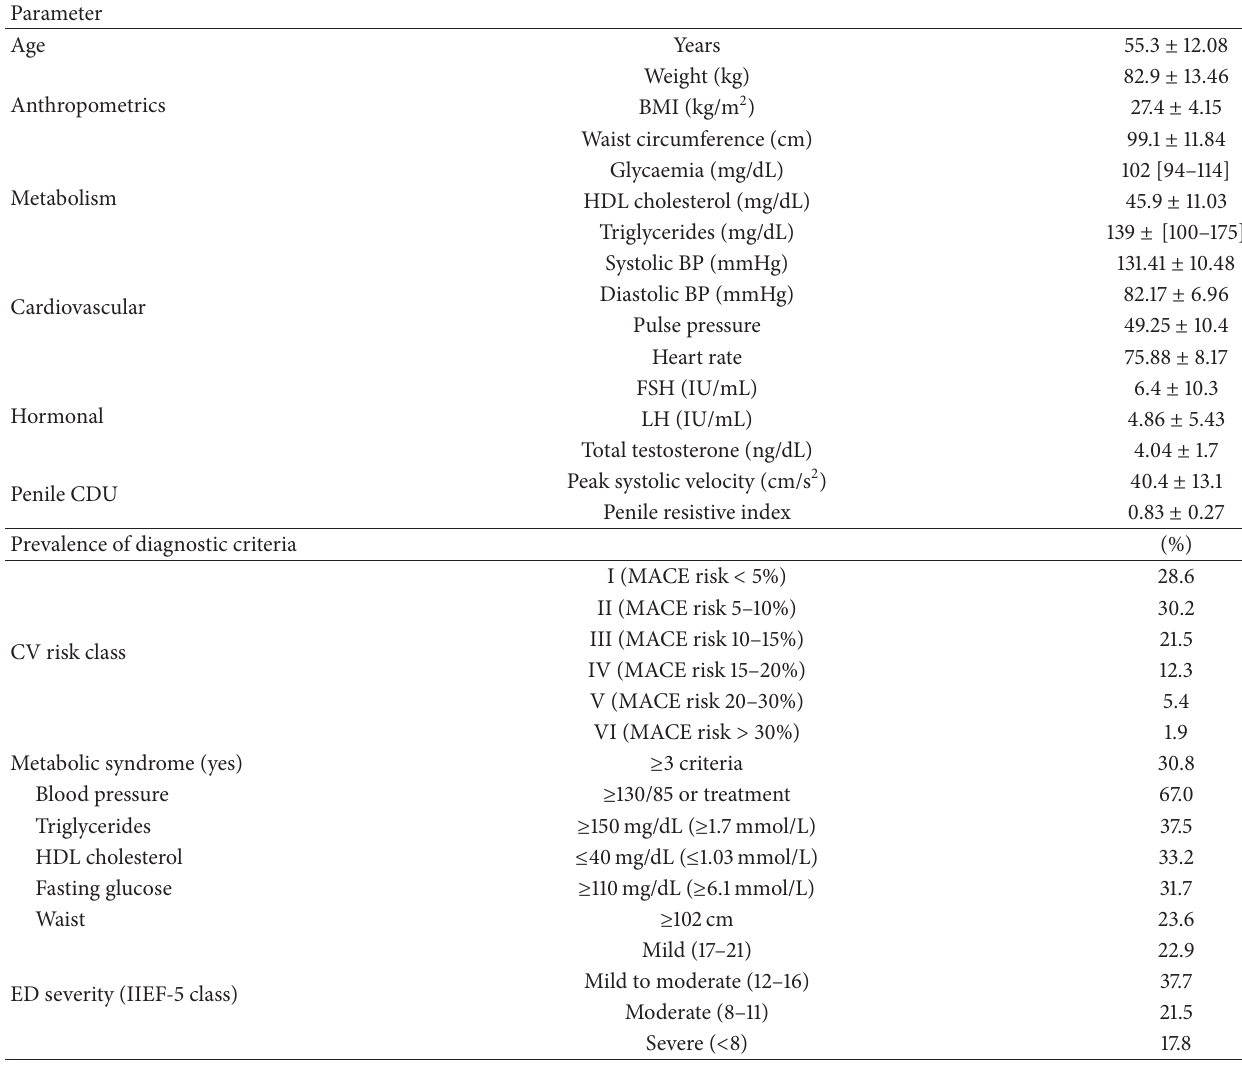
Table 1: Baseline parameters (604 recruited patients). Data are presented as mean ± standard deviation when normally distributed, median [ 25th–75th percentiles ] when skewed, and as percentages when